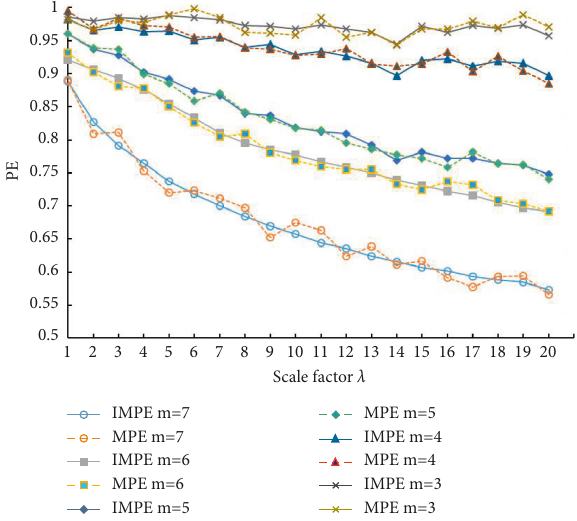
Figure 3: Permutation entropy of white Gaussian noise with different embedding